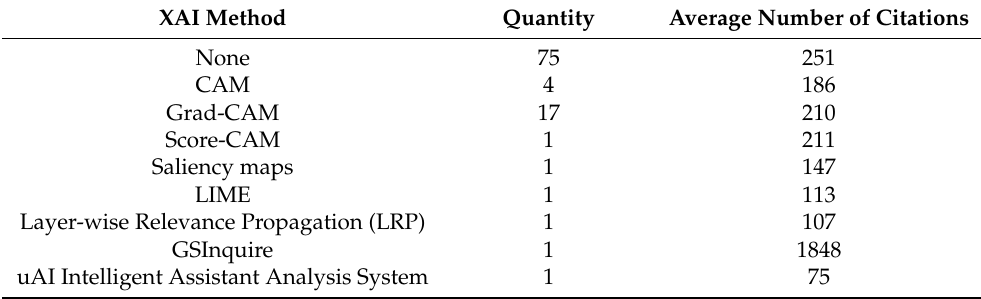
Table 12. Segmentation